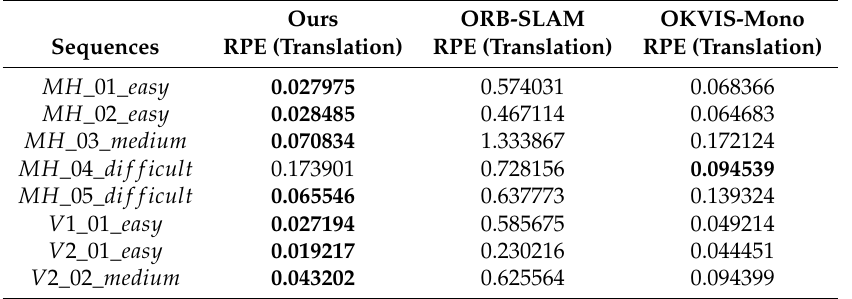
Table 2. Evo tool evaluation results on different algorithms. The table shows the error in the translation of the relative pose error (RPE) in meter. Bold numbers indicate that the estimated trajectory is closer to the true value.